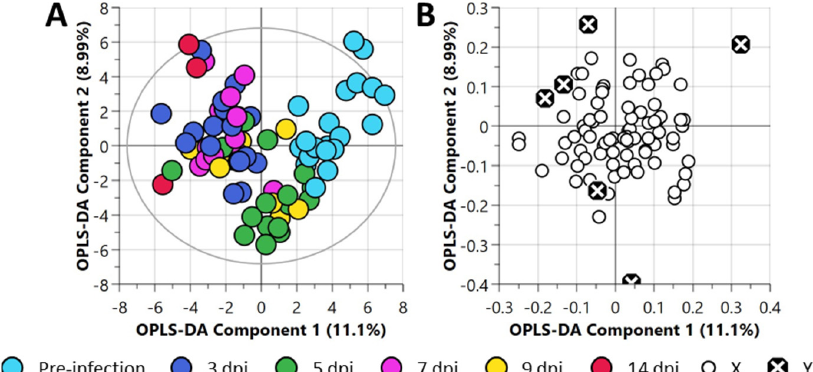
Figure 2. Orthogonal partial least square-discriminant analysis (OPLS-DA) of the central carbon metabolism metabolite dataset of nasal wash samples collected from ferrets. ( A ) OPLS-DA scatter plot and ( B ) OPLS-DA loadings plot. For this plot, R 2 X (cum) = 0.453, R 2 Y (cum) = 0.304, Q 2 = 0.108. The ellipse presented in panel ( A ) represents Hotelling’s T2 confidence limit (95%). The colored circles in panel ( A ) represent each analyzed sample, while the black crossed circles in panel ( B ) indicate the average group position for each sample cluster, with the white circles representing the distribution of metabolite features between these